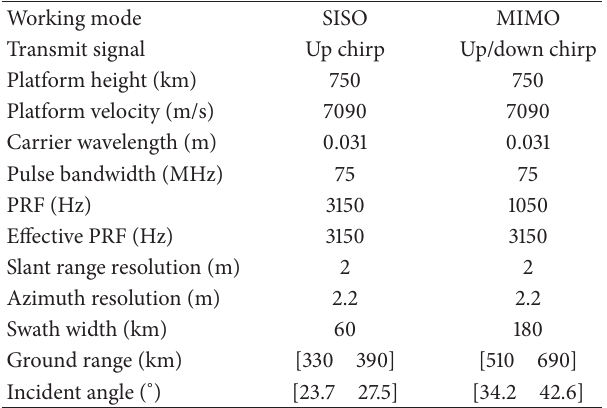
Table 1: Simulation SAR system parameters.